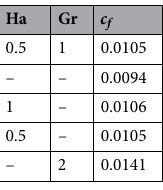
Table 2. Finite difference results for skin-friction.